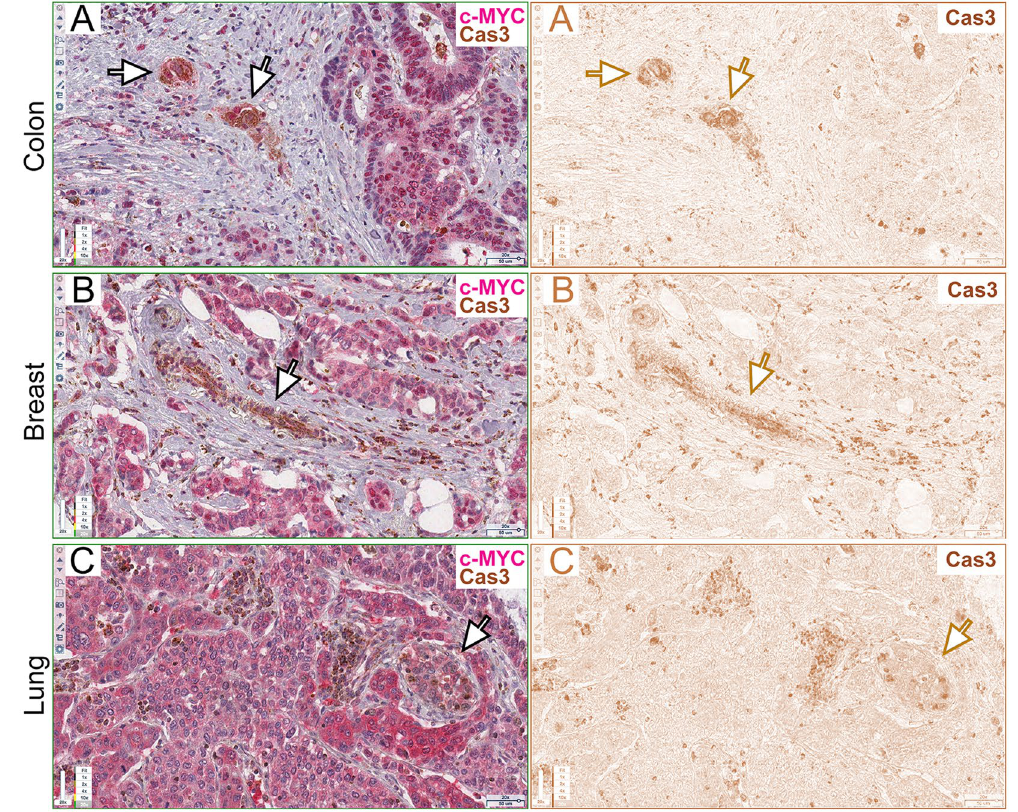
Figure 5. Human cancers display self-competitive behaviour. ( A – C ) c-MYC and Cas3 staining of colon ( A ), breast ( B ) and lung ( C ) human cancer samples. For each sample, the original RGB image (left panel) and the deconvolved DAB image (right panel) are shown. The arrows indicate groups of tumour cells positive to Caspase 3 staining. Scale bars are indicated in each